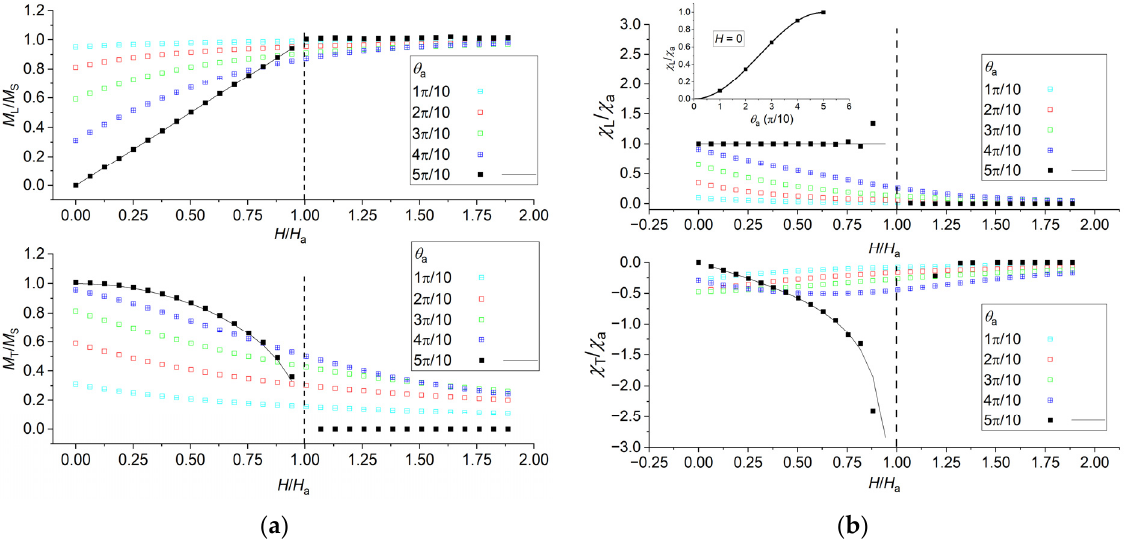
Figure 5. ( a ) Relative magnetization components ( M L / M S and M T / M S ) versus H / H a for different magnetic anisotropy direction θ a ; ( b ) Relative susceptibility components ( χ L / χ a and χ T / χ a ) versus H / H a for different magnetic anisotropy direction θ a . The full lines are theoretical values (Equation (8) for M L and M T , Equation (9) for χ L and Equation (10) for χ T ) and square are numerical results from model.